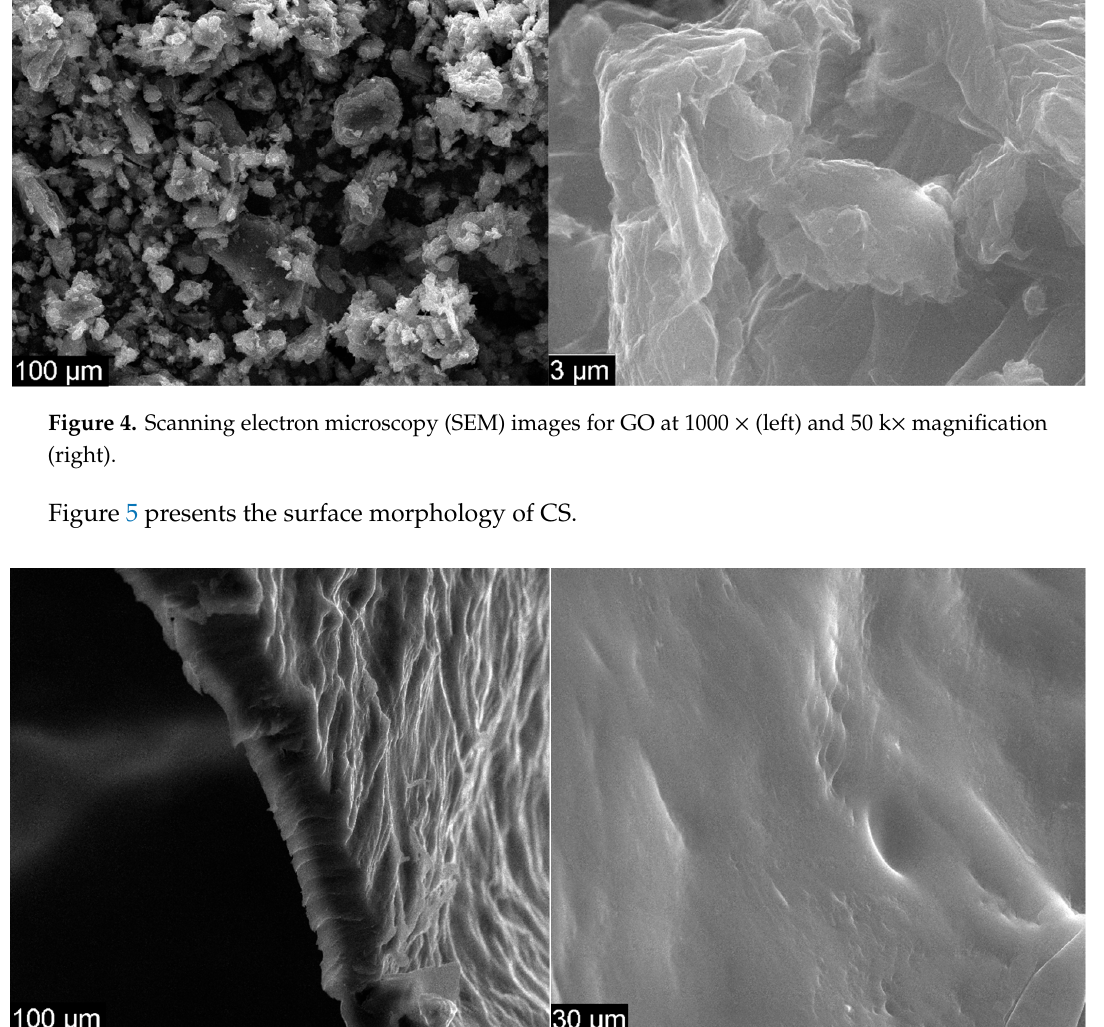
Figure 5. SEM images for CS at 1000 × (left) and 5000 × magnification (right)